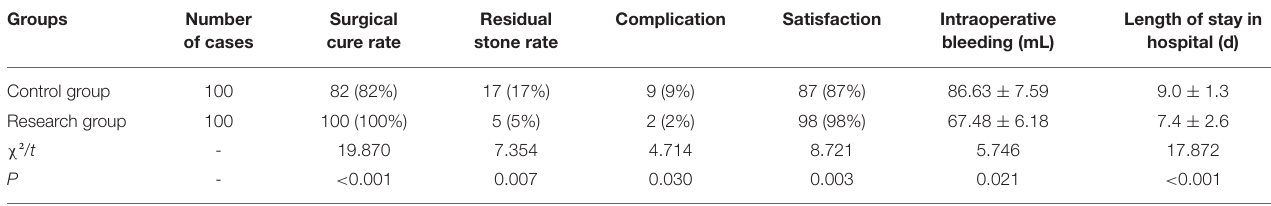
TABLE 3 | Cure rate and residual stone rate in both groups [n (%), ¯ x ± s].